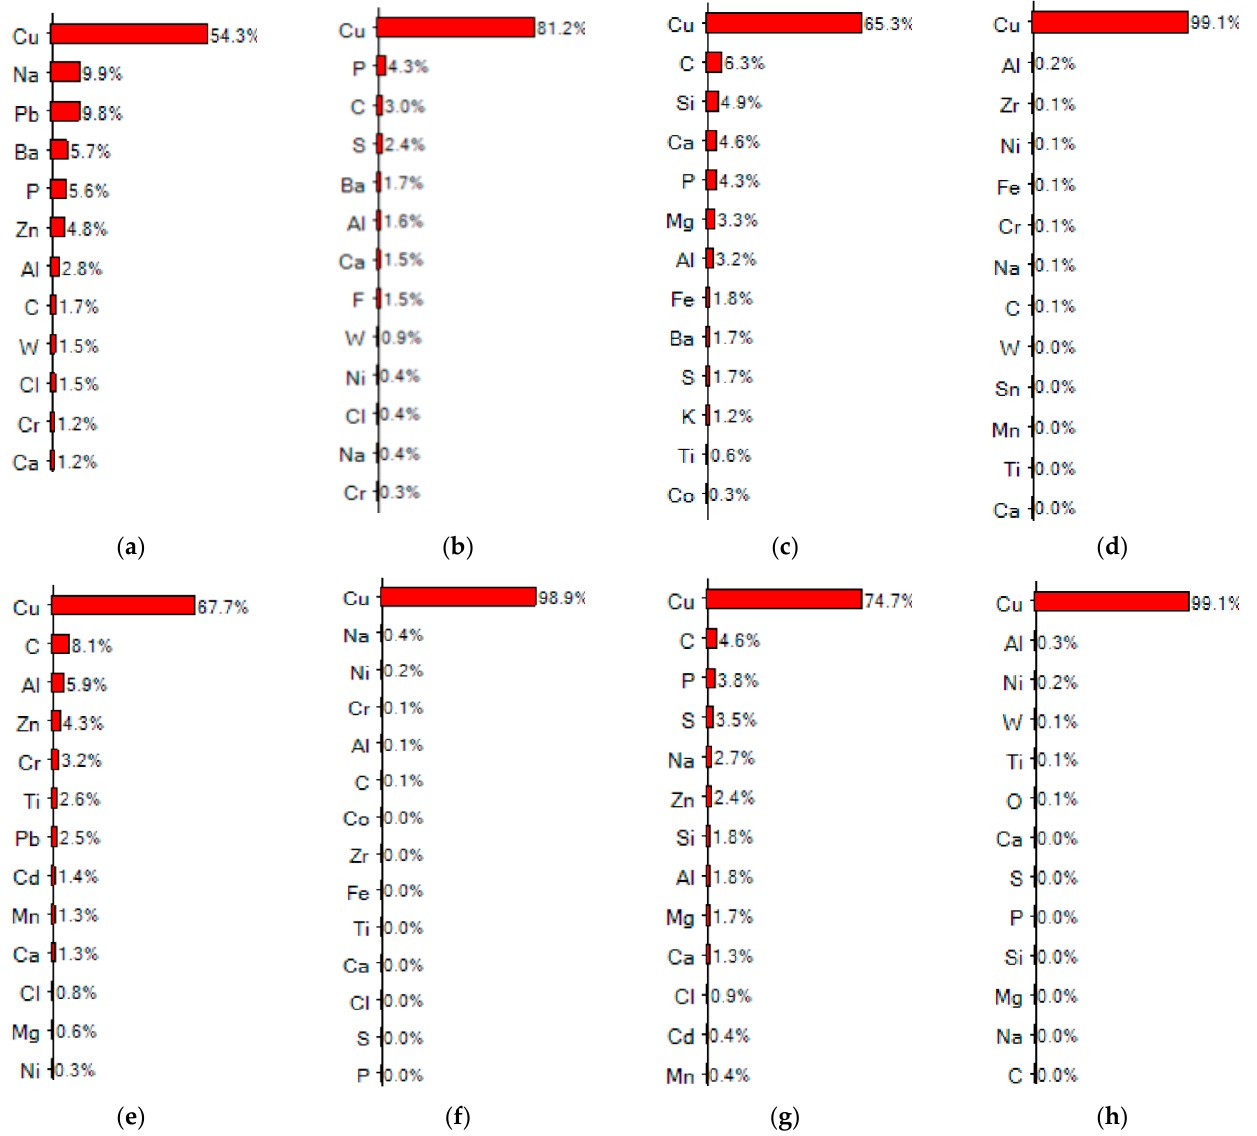
Figure 5. The EDX results for recycled Cu CCs show the composition ( a ) on the surface as-received without cleaning, ( b ) below the surface as-received without cleaning, ( c ) on the surface after cleaning by NMP, ( d ) below the surface after cleaning by NMP, ( e ) on the surface after cleaning by RO, ( f ) below the surface after cleaning by RO, ( g ) on the surface after cleaning by ethanol, and ( h ) below the surface after cleaning by ethanol.